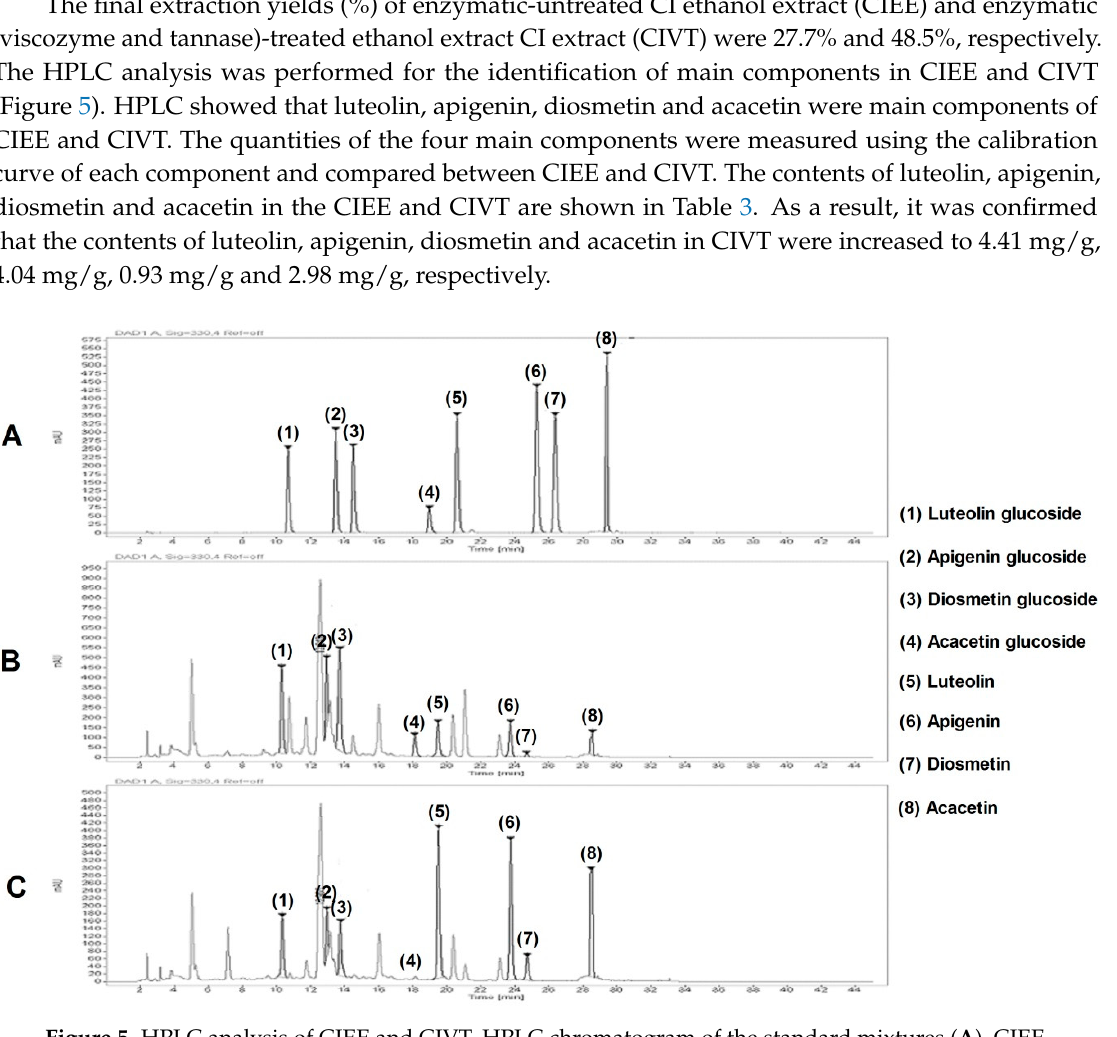
Figure 5. HPLC analysis of CIEE and CIVT. HPLC chromatogram of the standard mixtures ( A ), CIEE ( B ) and CIVT ( C ) was obtained according to the Materials and Methods. Table 3. Comparison of the main components from CIEE and CIVT.